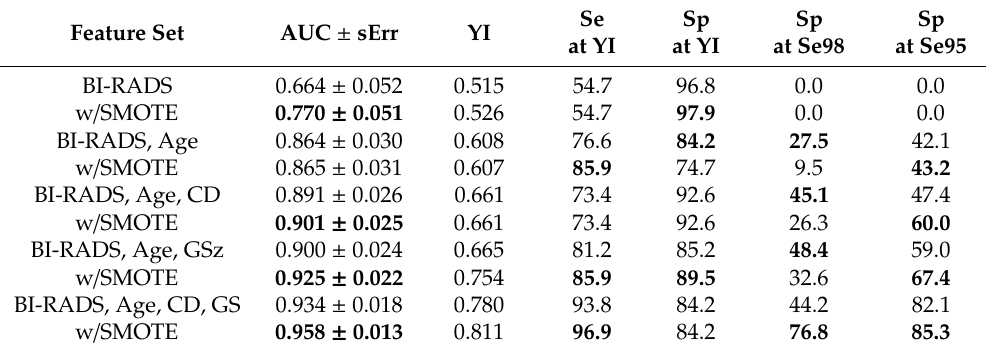
Table 2. Feature set AUC and Youden index performance with